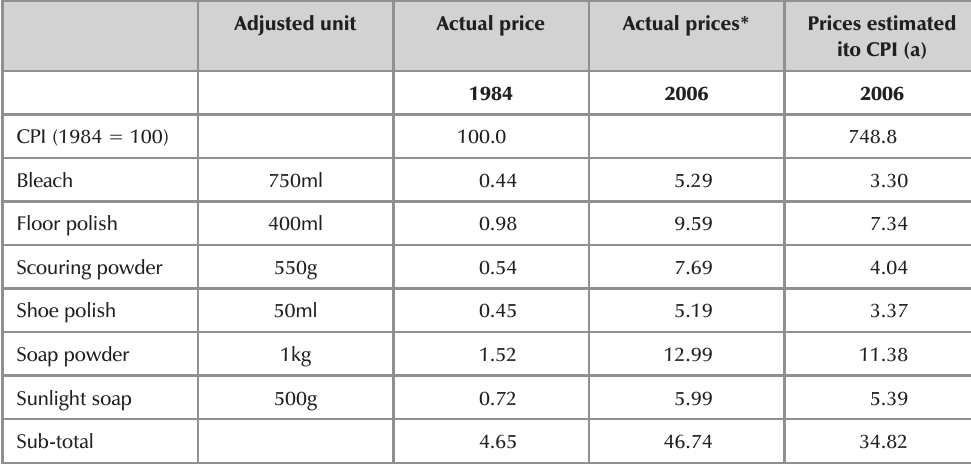
Table 2c Average prices of household consumables